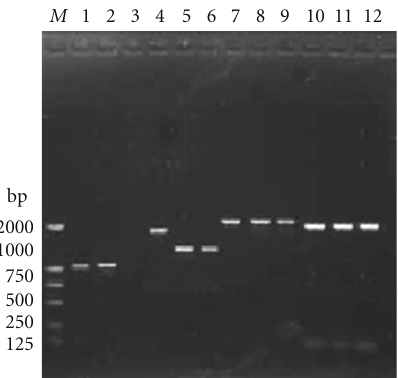
(a) Overall of PCR identification of the SP Δ asd ( Cm ) mutant Lanes 1, 2, 5, 6, 7, 8, 10, 11: the SP Δ asd ( Cm ) mutant; Lanes 3, 4, 9, 12:wt, Lanes 1, 2,3: Cm F /Cm R ; 4, 5, 6: asd P5/ asd P; 6, 7, 8, 9: asd P1/ asd P2; 10, 11, 12: asd P3/ asd P4